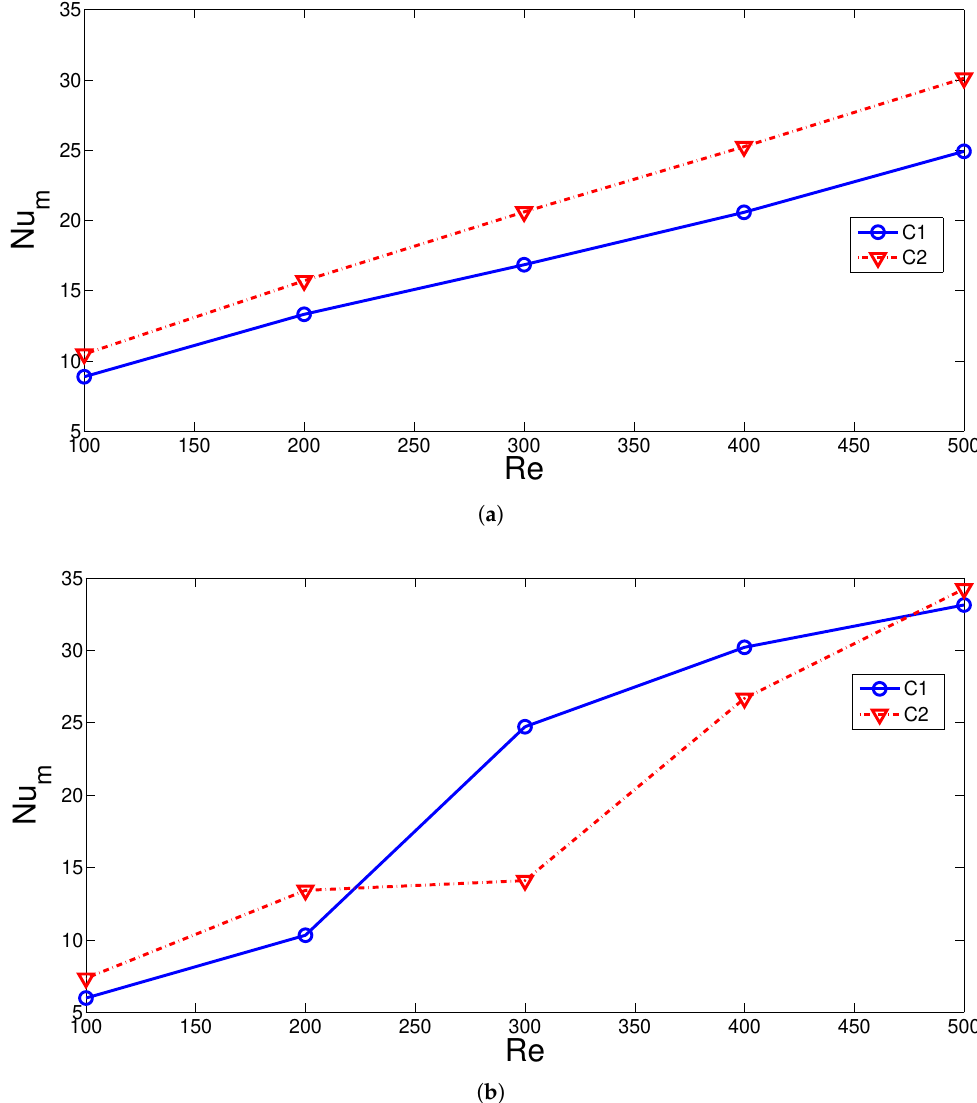
Figure 5. Effects of Re on the average Nu variations of hot cylinder C1 and cylinder C2 at two different rotational speeds (sc = 3Rc, Da = 0.01, HNF-2%). ( a ) Rew = 0; ( b ) Rew = −